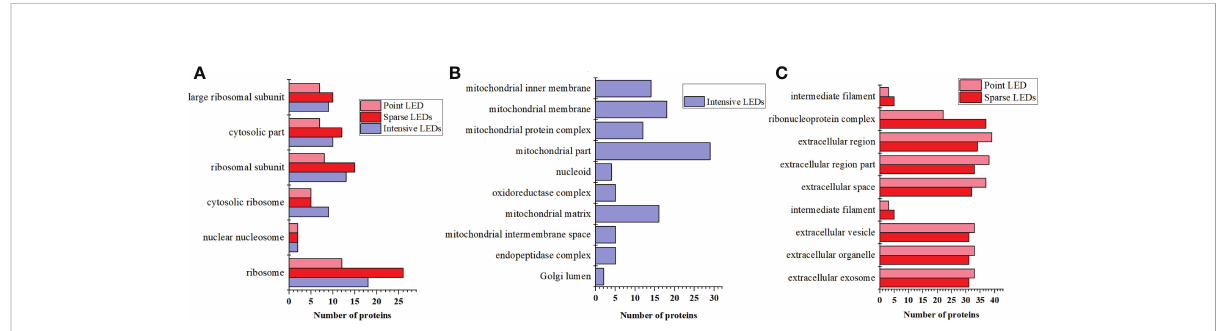
FIGURE 7 DEPs that were the same and different after three types of PDT: (A) The same DEPs after three types of PDT. (B) The unique DEPs induced by intensive LED-PDT. (C) The same DEPs after sparse LED-PDT and point LED-PDT.